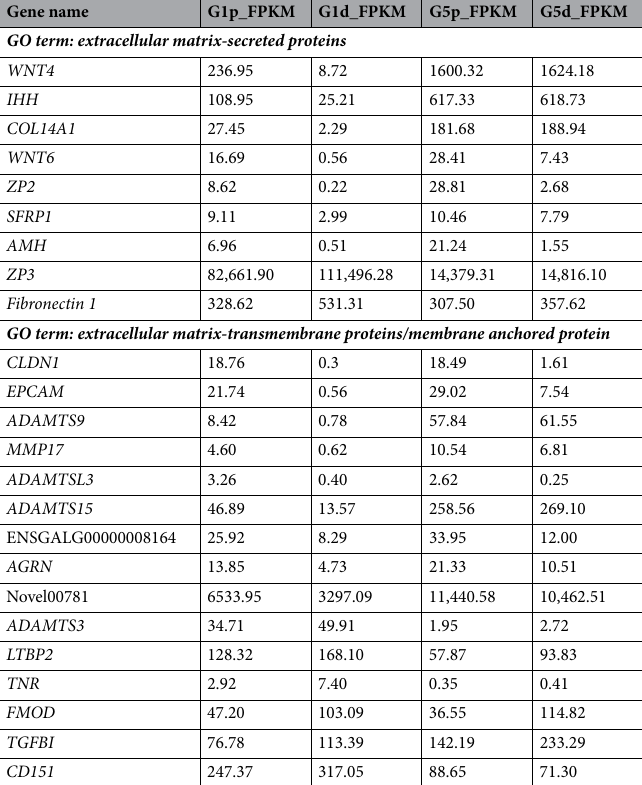
Table 4. The FPKM value of the genes involving the extracellular matrix from G1p, G1d, G5p and G5d